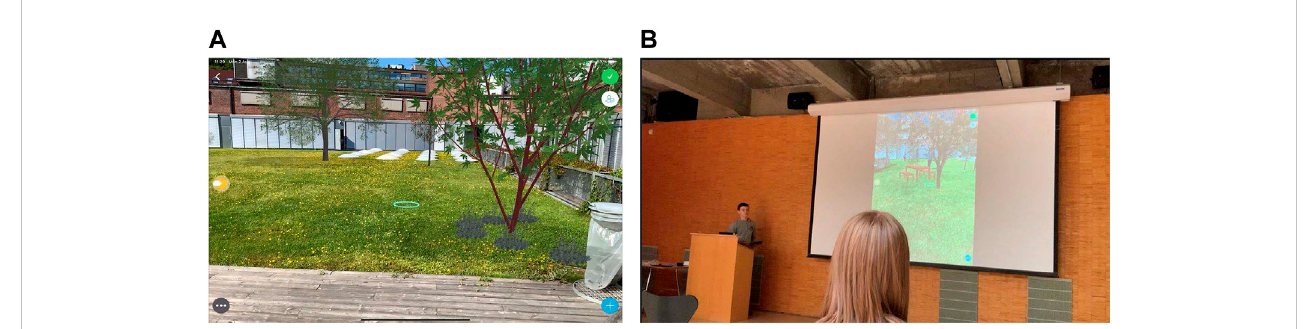
FIGURE 11 Panels (A, B) . Introduction to Case study. Panel (A) (Left): Participants training in a controlled setting for the fi rst task of the workshop. Panel (B) (Right): Participant presenting this fi rst work.